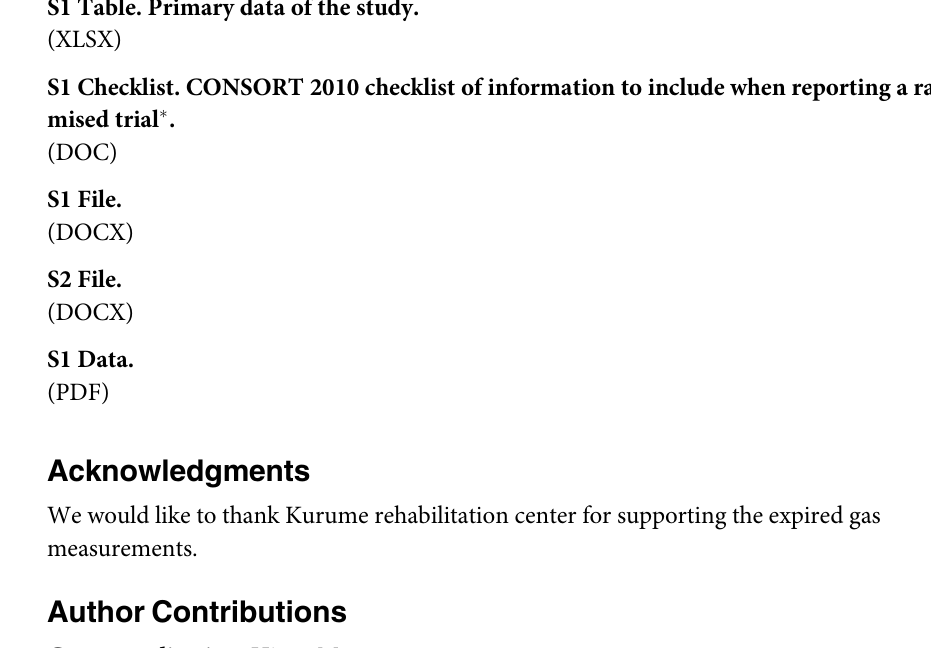
S1 Table. Primary data of the